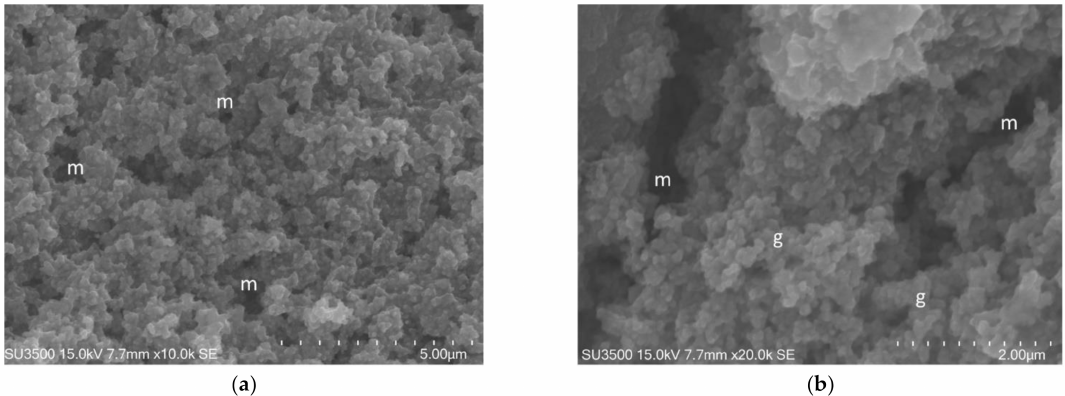
Figure 6. S. mutans prepared by the OsO 4 -RR-TA-IL procedure. ( a ) At high magnification, a well-developed micro- canalicular system, m, is visible in the spongy Eps, 10,000 × . Image was captured from the same sample observed in Figure 3b from [50]. ( b ). High voltage, high magnification, and high-resolution image of microcanalicular system, m. Fully hydrated Eps appears as a spongy structure formed by globular aggregate, g, at nanometric level, no filaments or collapsed network are visible, 20,000 × . Image was captured from the same sample observed in [50] Figure